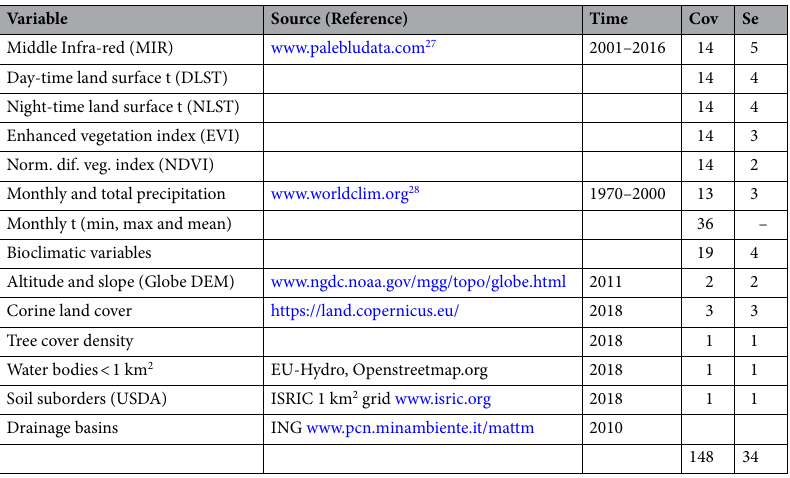
Table 3. List of screened covariates (Cov.) with reference to those selected (Se.) for implementing the